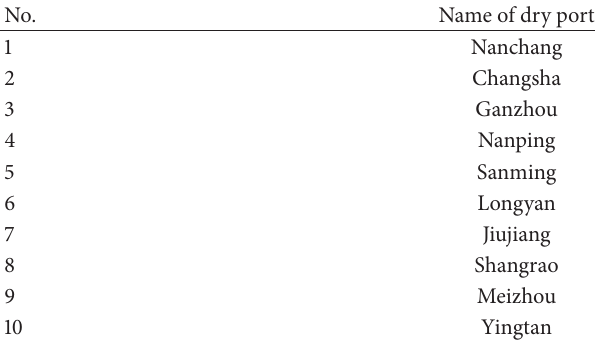
Table 3: Candidate dry